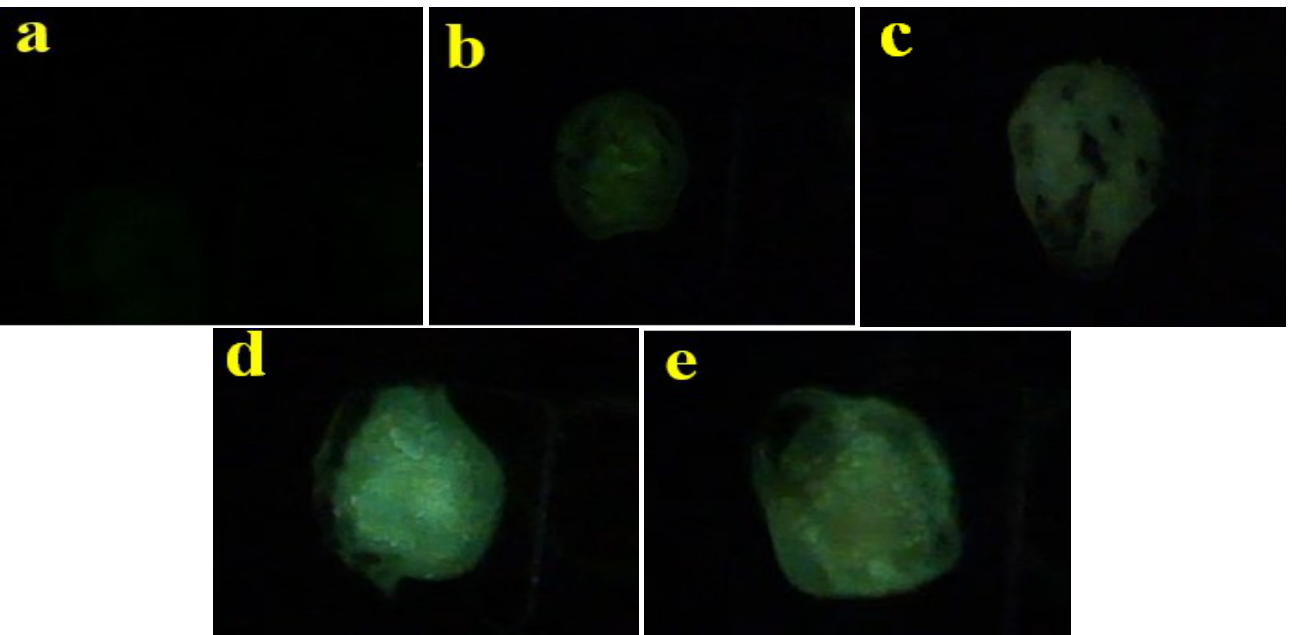
Figure 7. Optical imaging pictures of 5 samples under X-ray excitation ( a ) SrAl 2 O 4 , ( b ) SrAl 2 O 4 : Eu 2+ , ( c ) SrAl 2 O 4 : Eu 2+ , 0.1 %Dy 3+ , ( d ) SrAl 2 O 4 : Eu 2+ , 0.5 %Dy 3+ , and ( e ) SrAl 2 O 4 : Eu 2+ , 2%Dy 3+